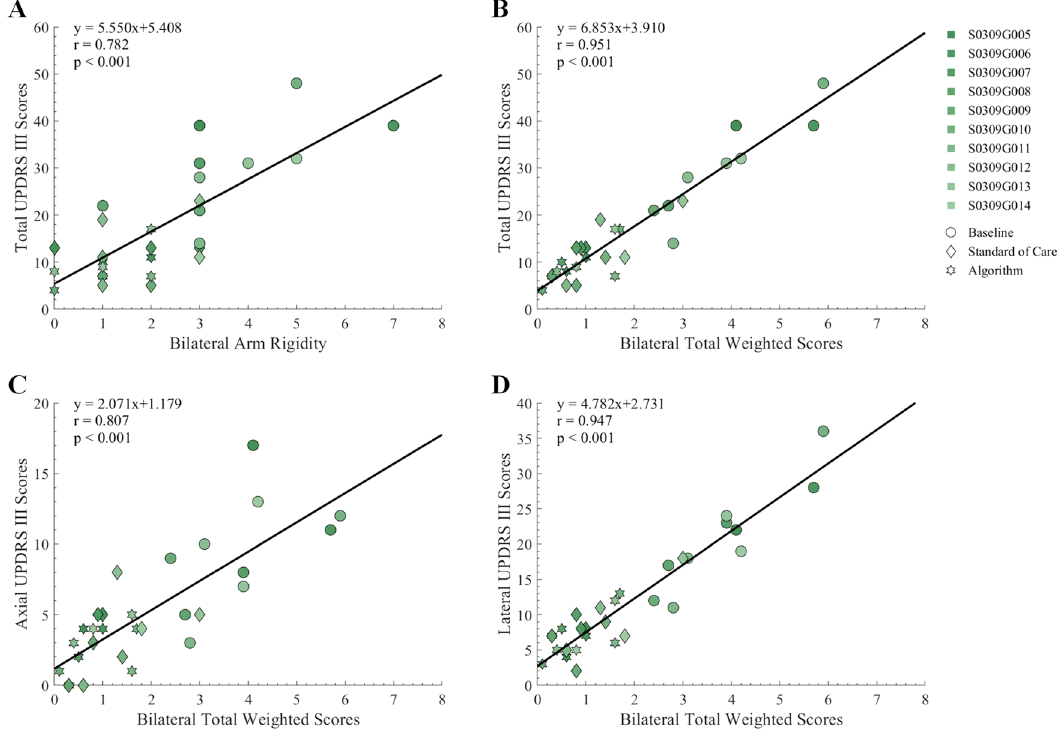
Fig. 2 Correlation of bilateral upper limb rigidity scores and total weighted scores with UPDRS III scores of all subjects ( n = 10). A Bilateral upper limb rigidity scores and B Bilateral total weighted scores correlation with total UPDRS III scores. C Axial symptoms UPDRS III scores and D Lateral symptoms UPDRS III scores correlation with bilateral total weighted